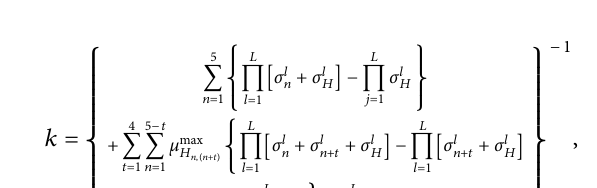
Table 9: Linguistic fuzzy reference comparisons between criteria. Expert Best expert